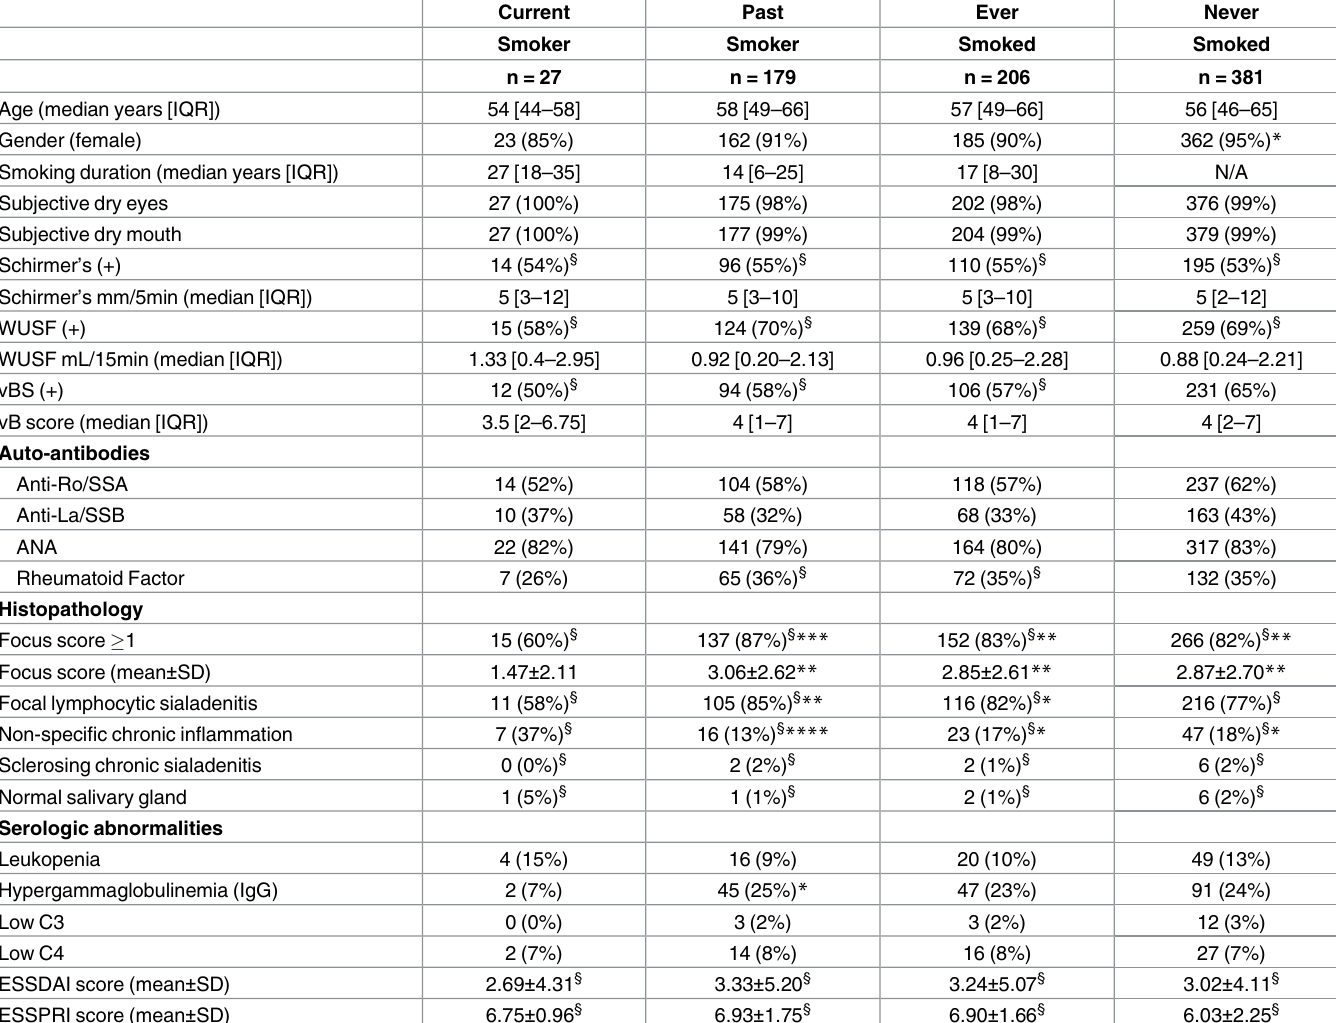
Table 4. Sociodemographic, clinical, and serological featuresof study participants with primary Sjo¨gren’s Syndrome a based on their smoking status.